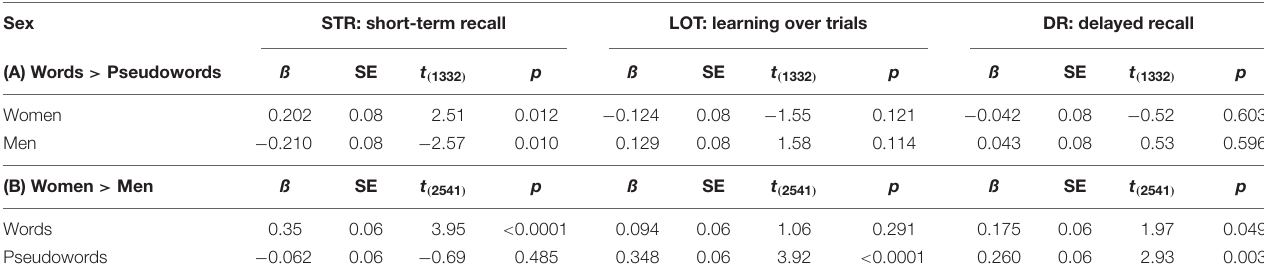
STR: short-term recall LOT: learning over trials